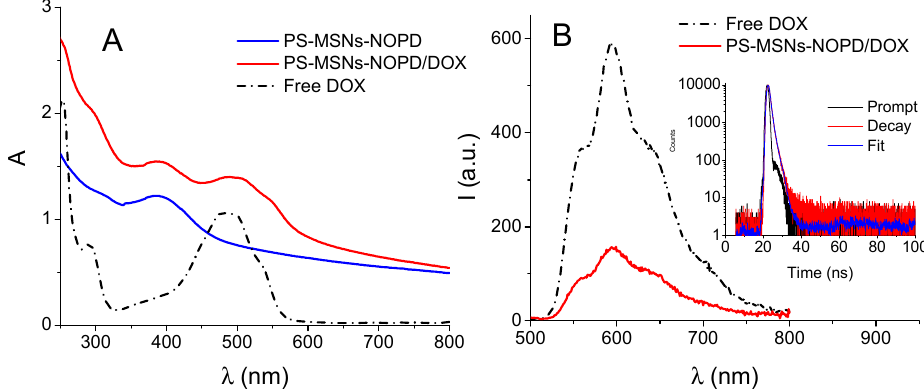
Figure 4. ( A ) Absorption spectra of free doxorubicin (DOX) and PS-MSNs-NOPD and PS-MSNs-NOPD/DOX suspensions (1 mg mL − 1 ) in PBS (pH 7.4, 10 mM). ( B ) Fluorescence emission spectra ( λ exc = 490 nm) of free DOX and PS-MSNs-NOPD/DOX suspension (1 mg mL − 1 ) in PBS (pH 7.4, 10 mM). The two samples are optically matched at the excitation wavelength. The inset shows the fluorescence decay and the related biexponential fitting for the PS-MSNs-NOPD/DOX suspension ( λ exc = 455 nm, λ em = 590 nm).